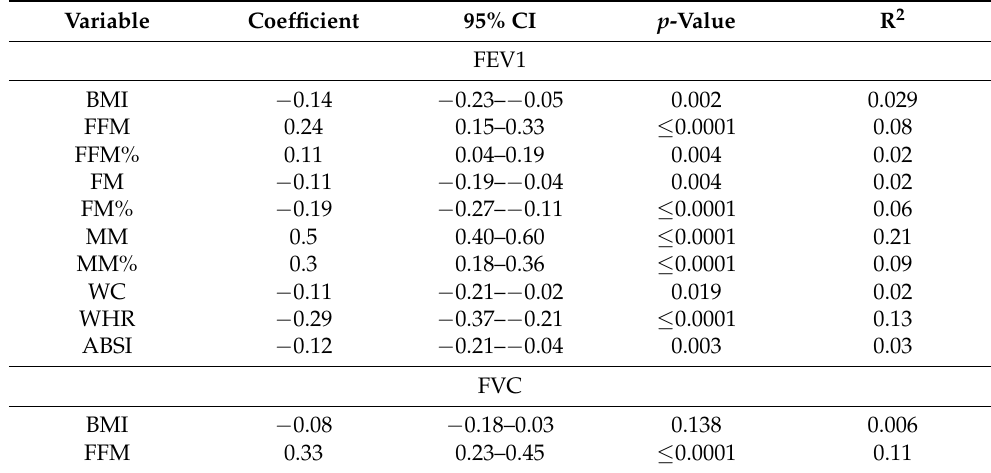
Table 2. Univariate regression analysis of FEV1, FVC, and FEV1/FVC in male